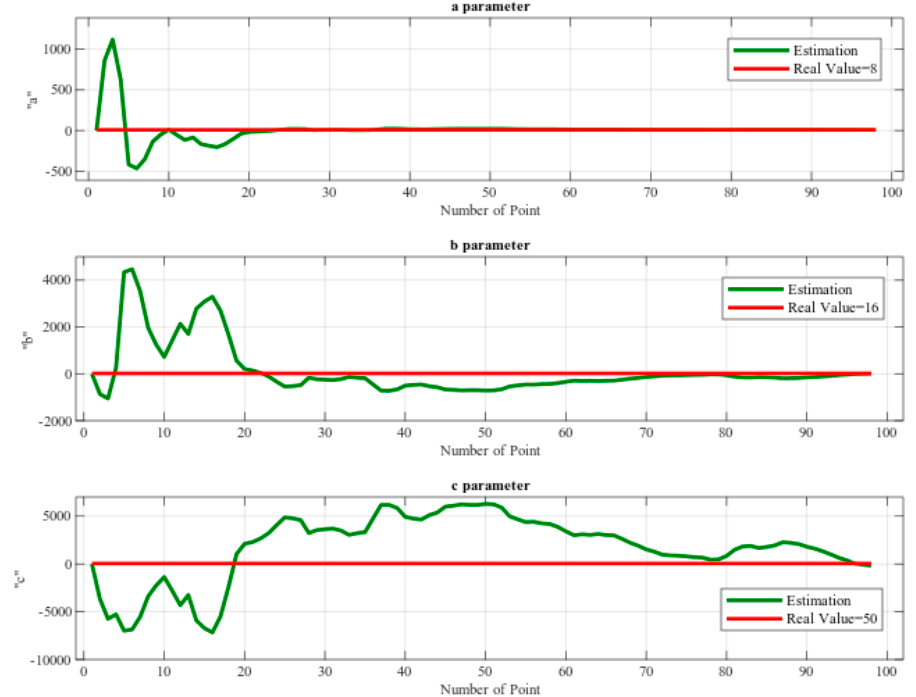
Figure 23. The simulation result of predicting ‘ a ’, ‘ b ’ and ‘ c ’ parameters from the parabolic detection.